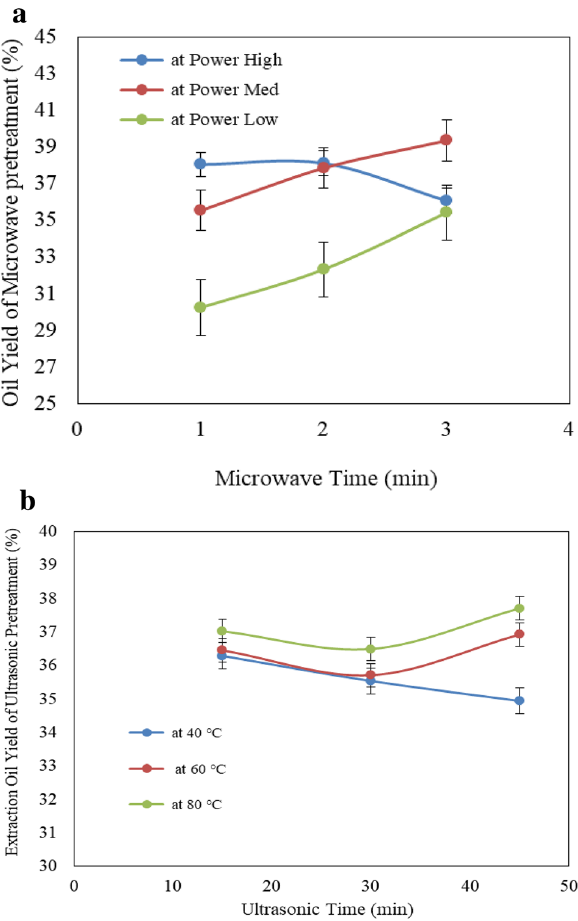
Figure 8. ( a ) Effect of microwave condition on oil extraction yield. ( b ) Effect of ultrasonic condition on oil extraction